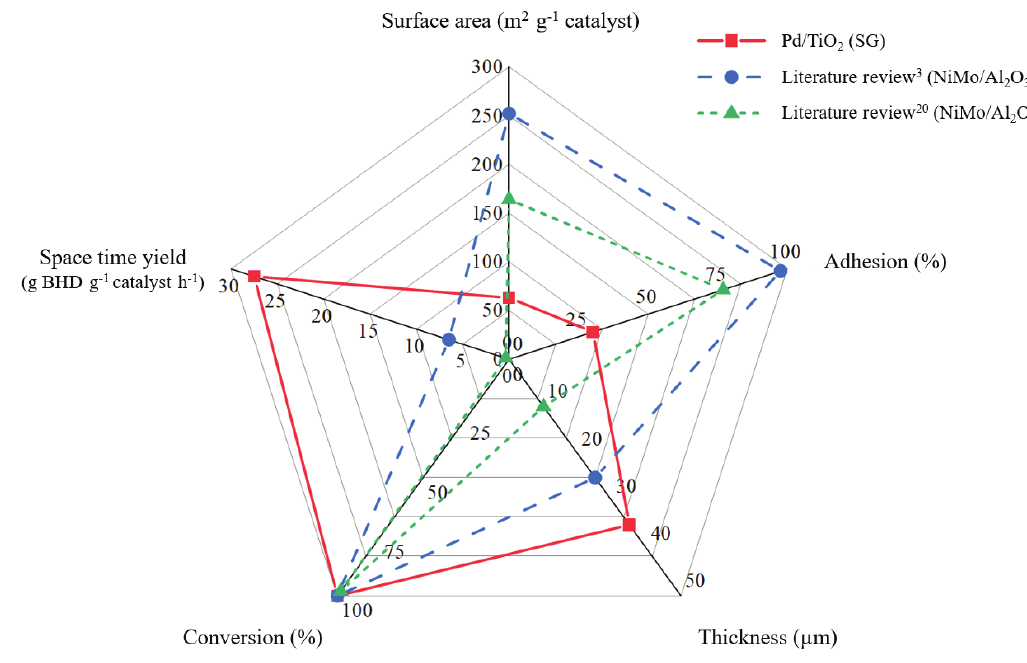
O (SUS), Pd/Al 2 3